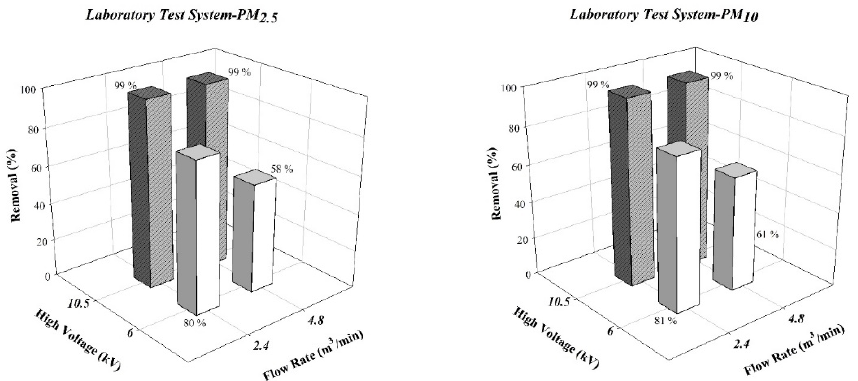
Figure 4. Experimental results of particle in the laboratory test system.